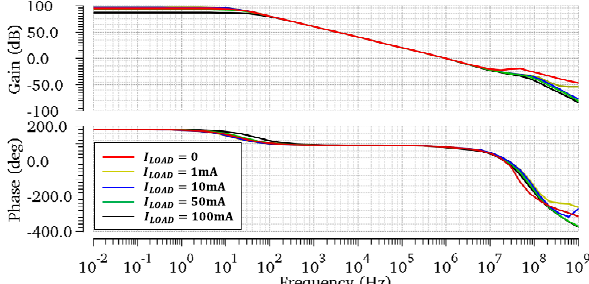
Figure 6. Simulated open − loop gain at different load currents with 𝐶 (cid:3013) = 100 pF .